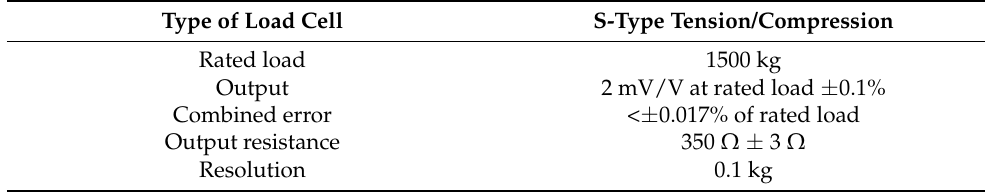
Table 2. Specifications of load